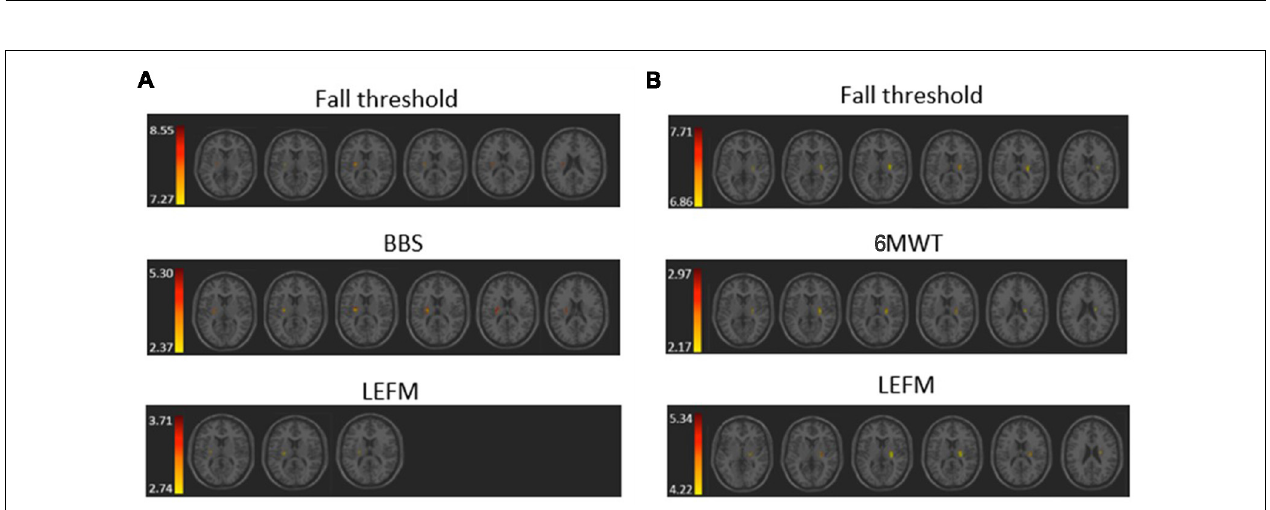
Frontiers in Human Neuroscience |